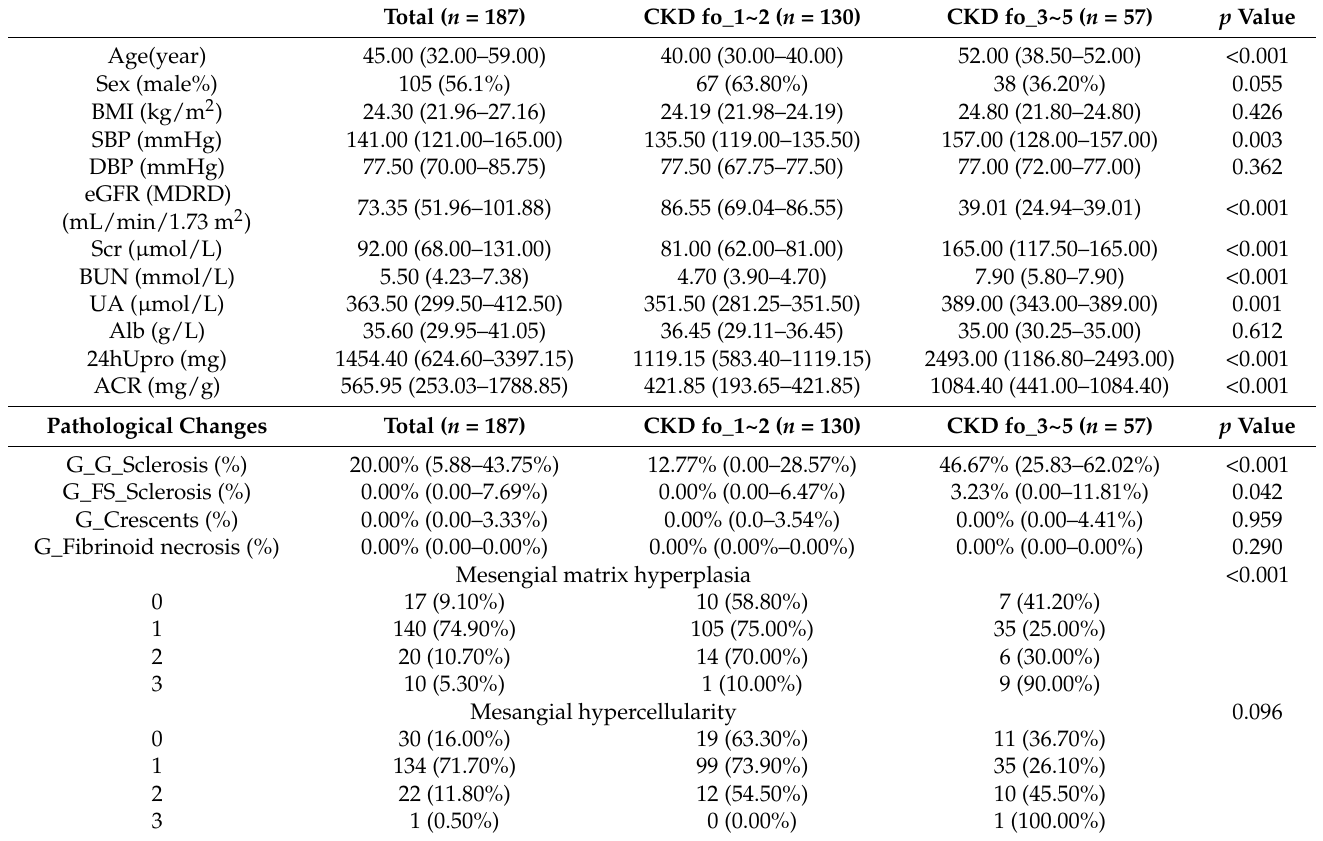
Table 1. Baseline characteristics of the study